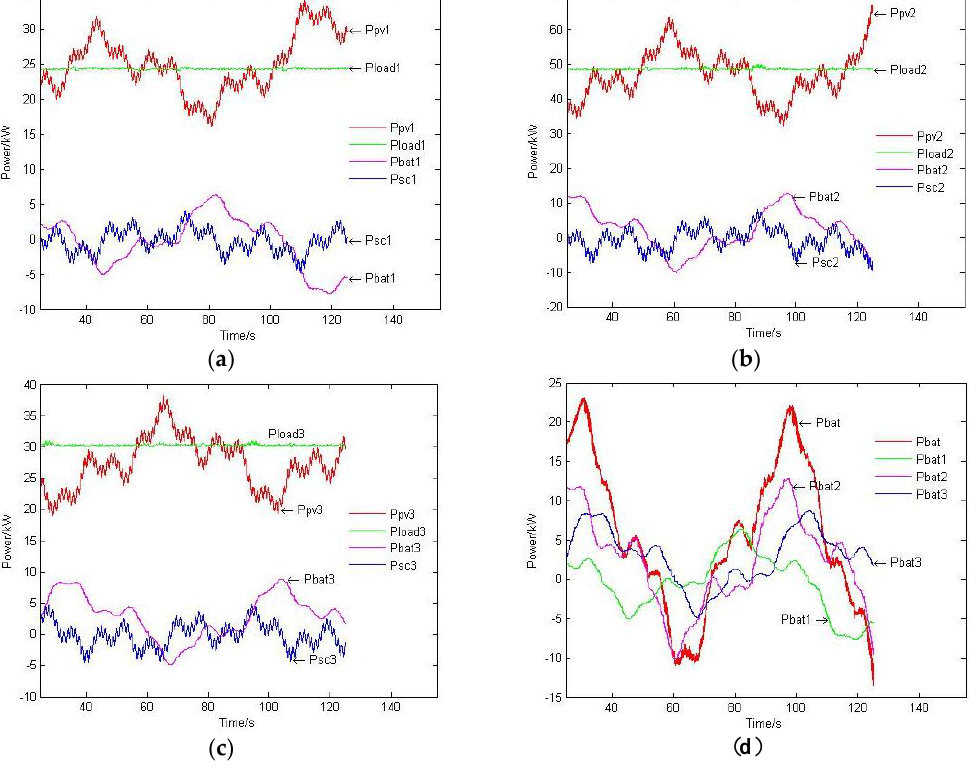
Figure 12. ( a ) Distributed storage system 1; ( b ) Distributed storage system 2; ( c ) Distributed storage system 3; ( d ) Waveforms of battery power.